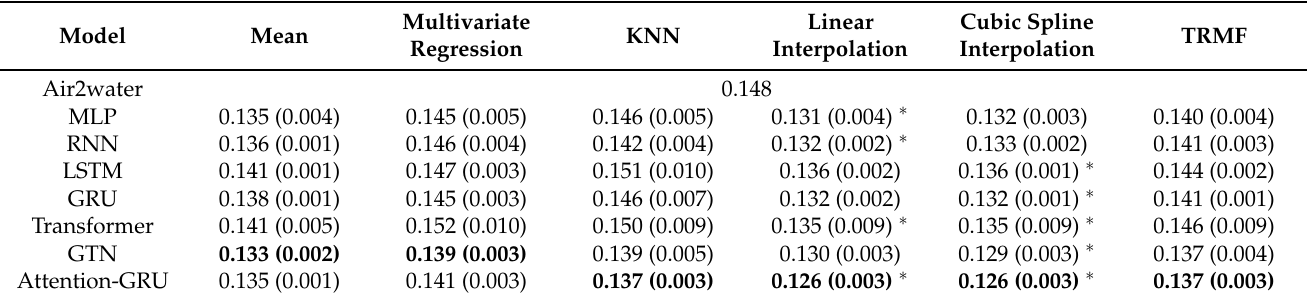
Table 5. The values of the evaluation index MAPE. The values in the table represent the mean (standard deviation) of the ten experimental results. The best prediction model results for each missing value imputation method are shown in bold. “ ∗ ” represents the best result for the prediction model.